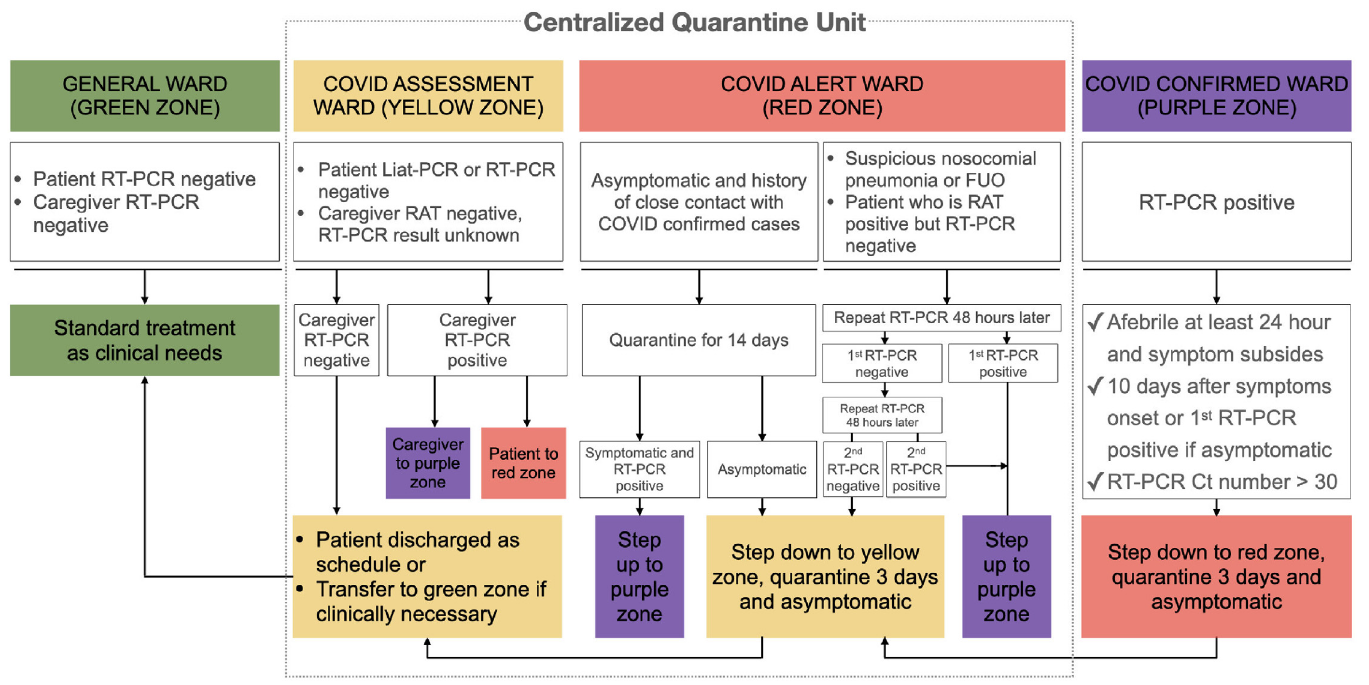
Fig 2. Flowchart of the triage admission protocol with a centralized quarantine unit. RAT, rapid antigen test; FUO, fever of unknown origin.